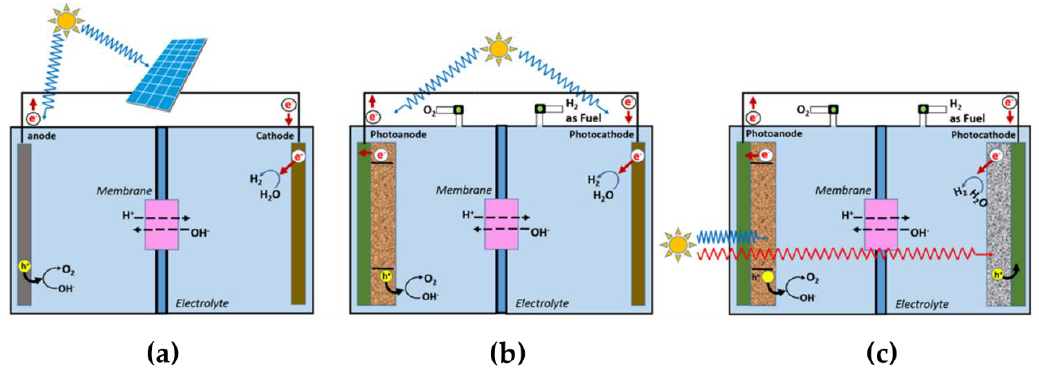
Figure 3. Schematic diagram of photoelectrochemical (PEC) photovoltaic (PV)–PEC hybrid water splitting system; ( a ) PV/PEC hybrid cell, ( b ) A photoelectrode PEC cell with anode and cathode combined in parallel, and ( c ) Two photoelectrodes combined in series [3]. Copyright 2010, Royal Society of Chemistry.